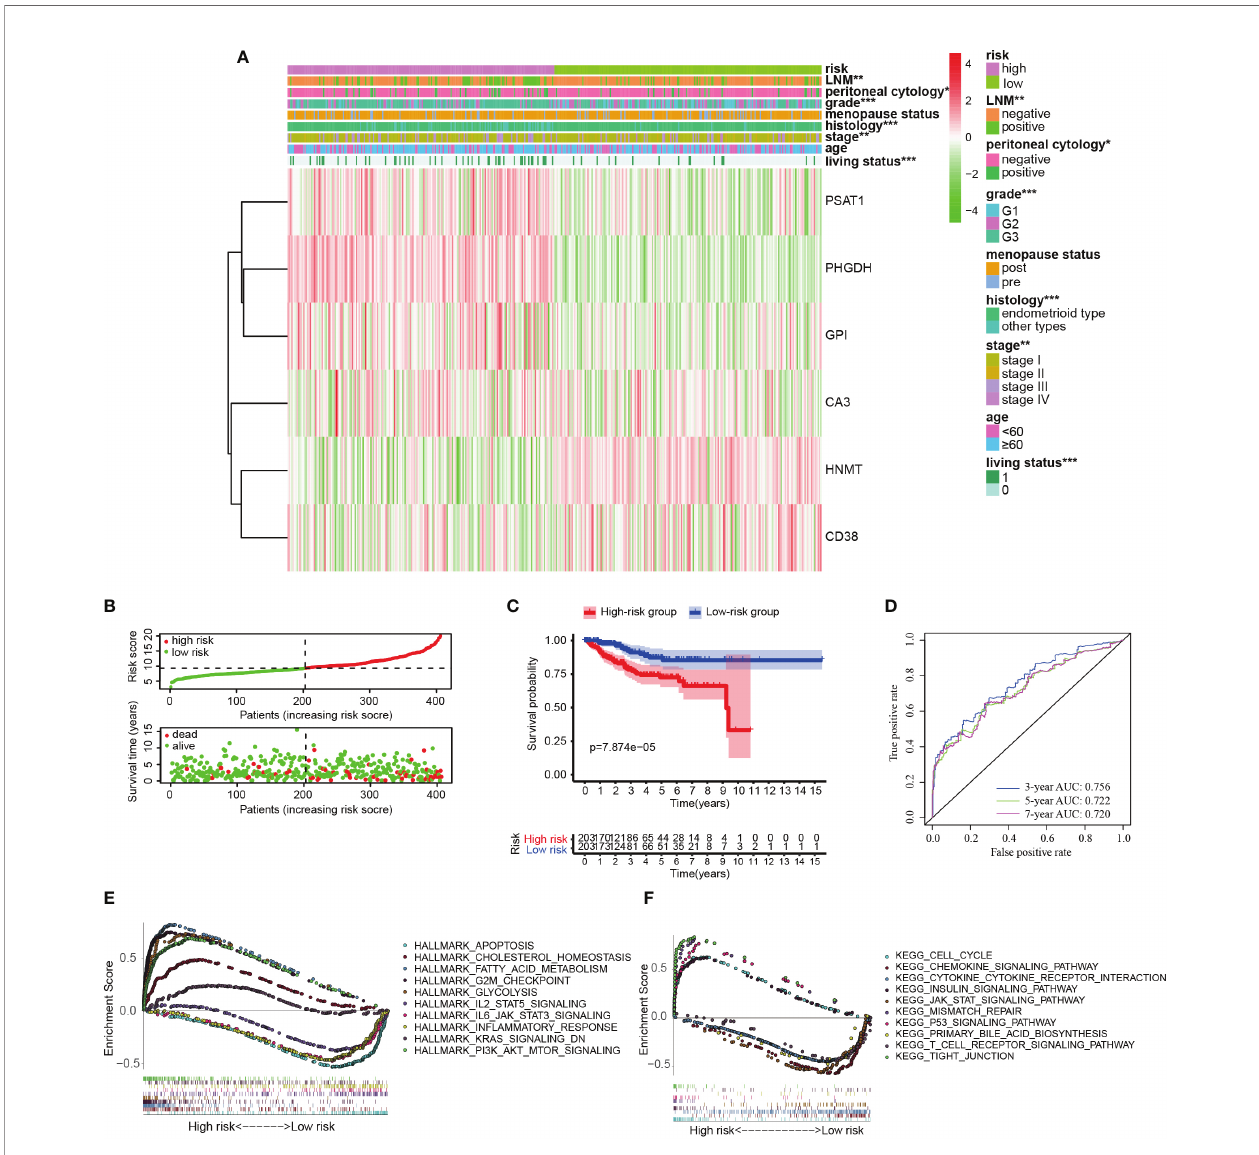
FIGURE 3 | Different clinicopathological factors and OS of EC in metabolism-related risk signature. (A) Heatmap of clinicopathological factors and the six hub genes in the high-risk and the low-risk groups. P-value is represented by * (P < 0.05), ** (P < 0.01), and *** (P < 0.001); (B) Distribution of the risk score based on the set of six metabolic genes and living status in the two groups; (C) Survival curves of the two groups; (D) Time-dependent ROC curves for 3-, 5-, and 7-year survival prediction; The GSEA results based on risk groups in 216 EC patients of (E) hallmarker and (F) kegg results of the nomogram (p = 4.191e-02) ( Figure 5I ). The nomogram was proved to be accurate in the prediction of OS.